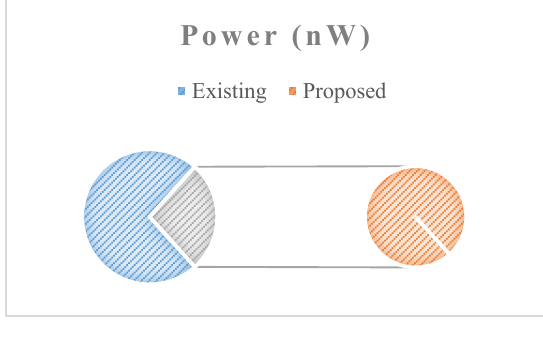
Figure 20. Comparison for existing SCC and proposed